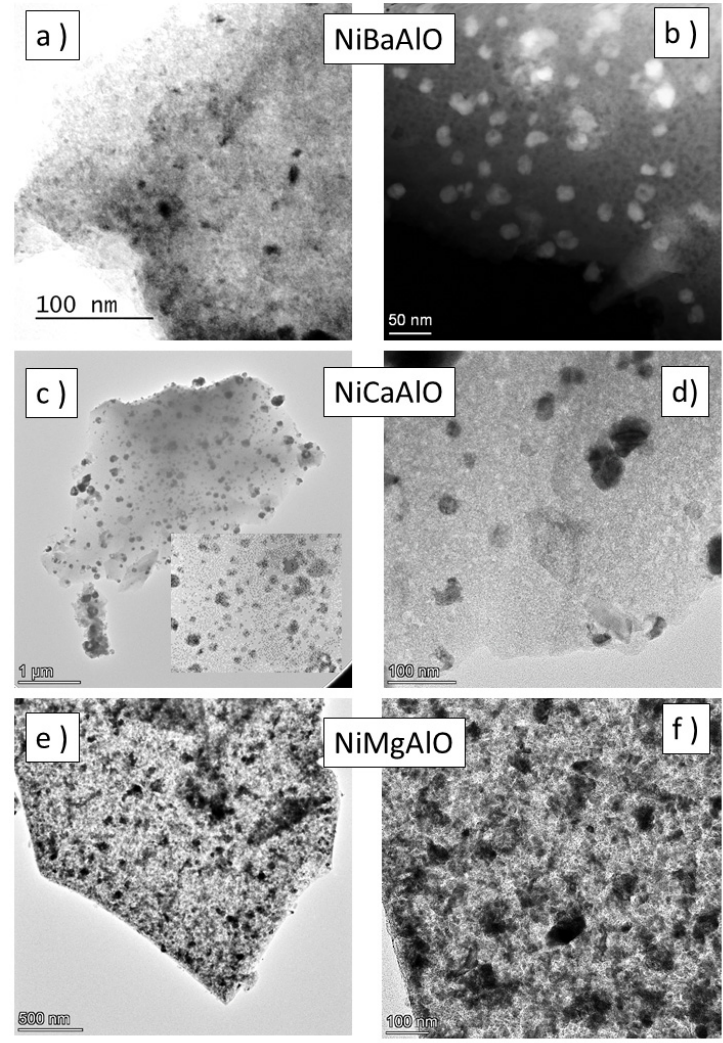
Figure 3. TEM images of ( a , b ) NiBaAlO, ( c , d ) NiCaAlO, and ( e , f ) NiMgAlO samples, where brighter/darker (depending on the type of field used) spots correspond to NiO particles.